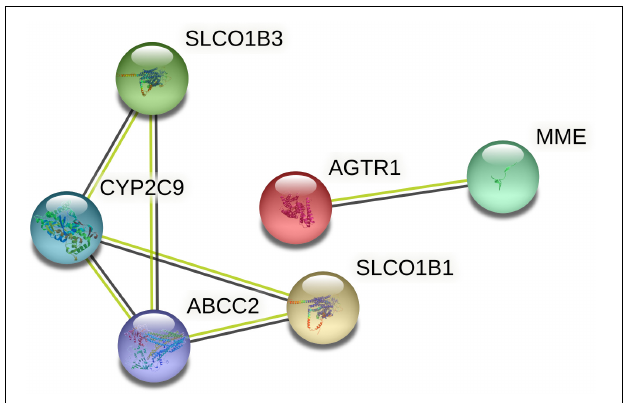
FIGURE 2 | PPI network of the DPTs of SV constructed by STRING.